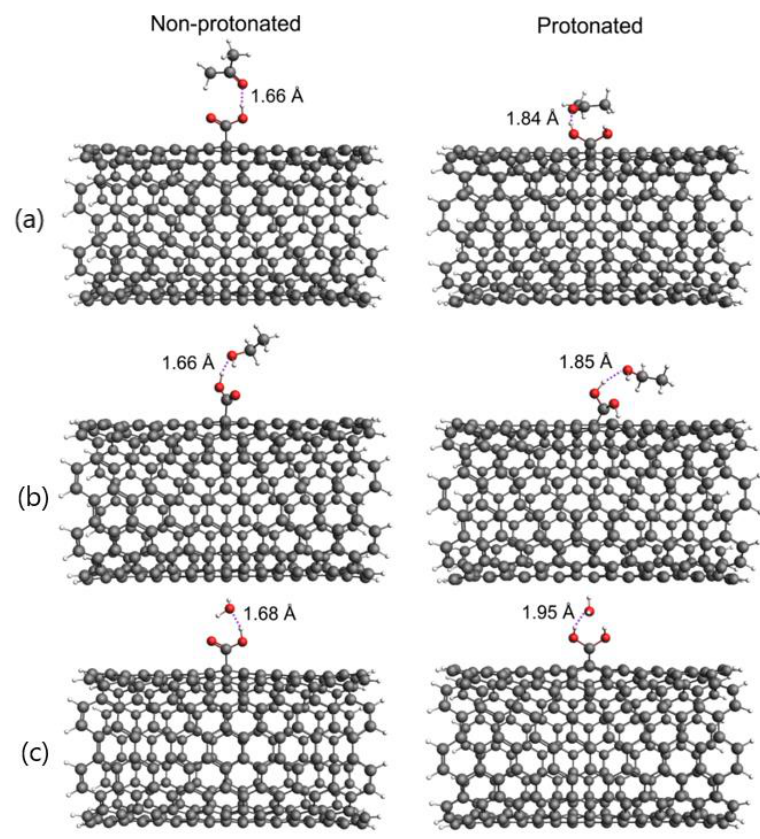
Figure 2. DFTB/GFN-xTB optimized systems with intermolecular distances between nanotubes and ( a ) acetone, ( b ) ethanol and ( c ) H 2 O .